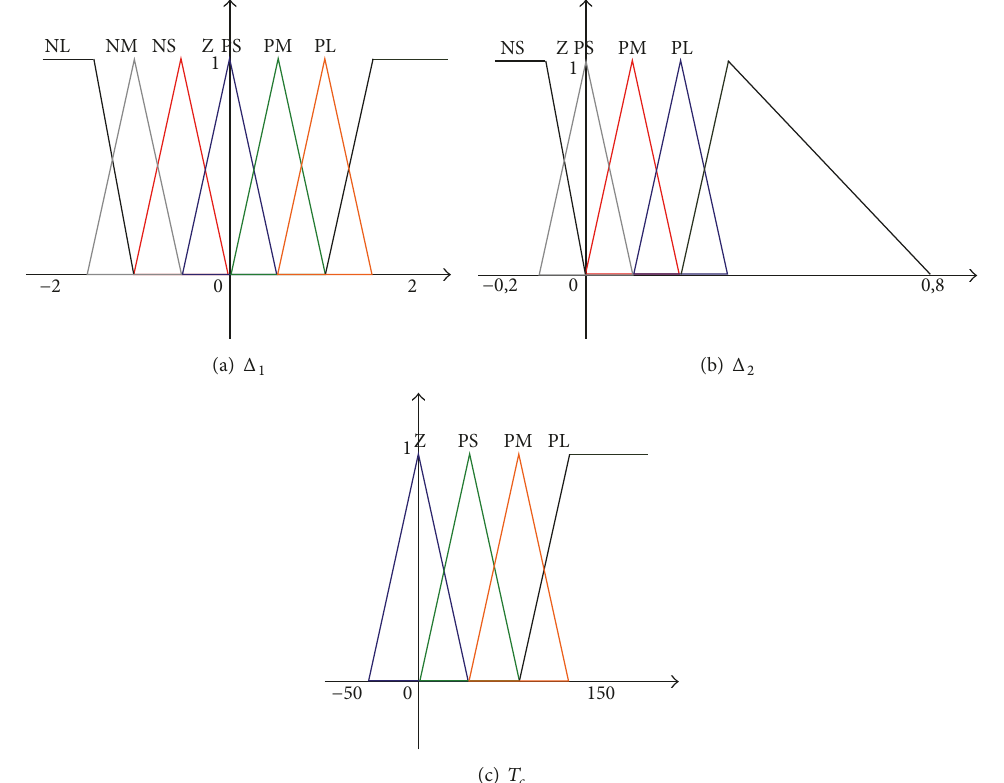
Figure 12: Membership functions for fuzzy input and output variables.